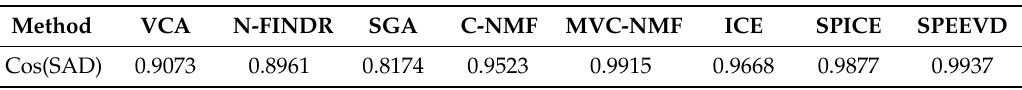
Table 6. The cosine of SAD values between the extracted endmember and the USGS library spectra.